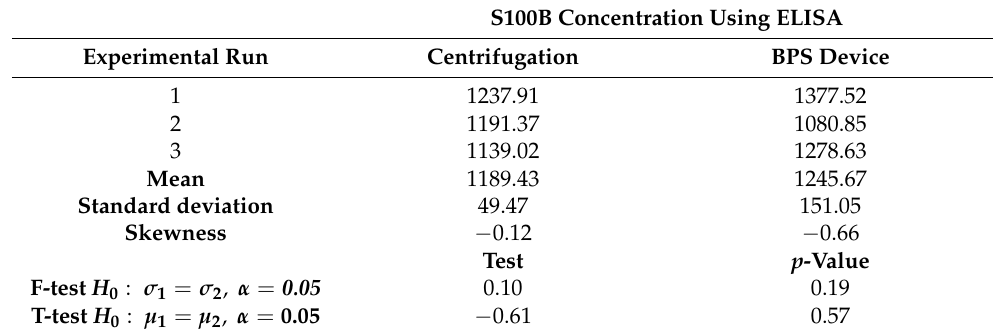
Table 5. Statistical comparison of conventional and paper-based blood plasma separation for measur- ing S100B at 1000 pg/mL using